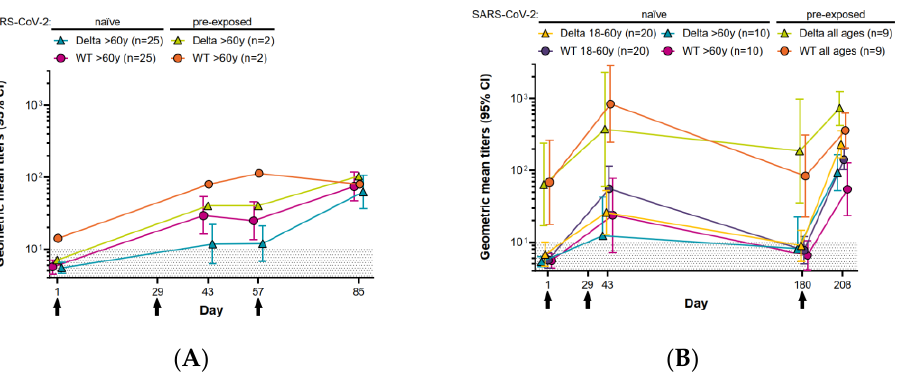
Figure 1. Neutralizing antibody response against wild-type SARS-CoV-2 virus and Delta variant after CVnCoV vaccination . The geometric mean titers (GMTs) of neutralizing antibodies with 95% confidence intervals (CIs) to wild-type (WT; filled circles) and Delta (filled triangles) are shown. ( A ) Participants aged >60 years with a third dose on Day (D)57 and ( B ) participants aged 18–60 years and >60 years with a third dose on D180. SARS-CoV-2-naïve (seronegative for N protein throughout the trial period) and SARS-CoV-2-pre-exposed (seropositive for N protein at baseline) participants are indicated by color. The black arrows indicate the days of vaccinations: D1 (baseline), D29 ( A , B ) and D57 ( A ) or D180 ( B )). n = number of participants with available data per group for all time points. Values above the black-dotted region ( ≥ 10) were considered positive. Table 1. Geometric mean titers, seroconversion rates and geometric mean fold rises of Delta and wild-type neutralizing antibodies 28 days after 2 (D43) and 3 (D85 and D208) CVnCoV doses in SARS-CoV-2-naïve participants.